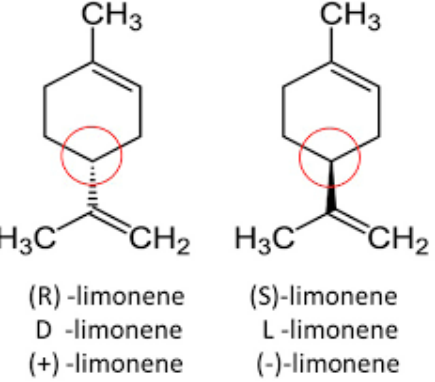
Figure 1. The structural formulas of isomeric D- and L-limonenes.